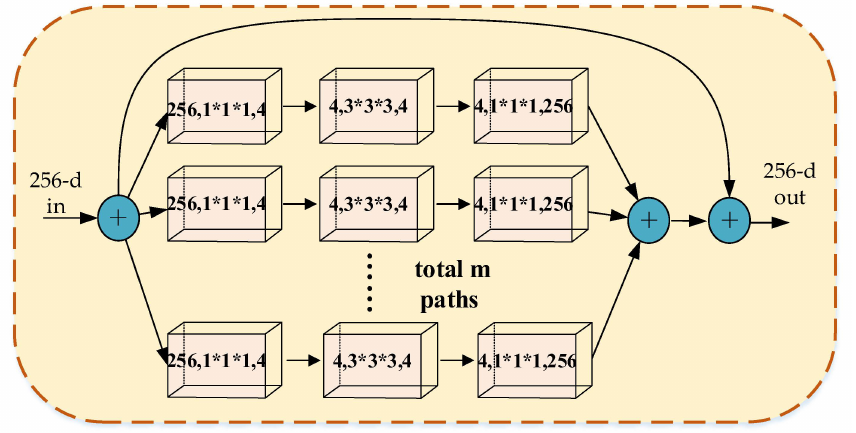
Figure 6. Block 2 of Branch-Fusion Net.